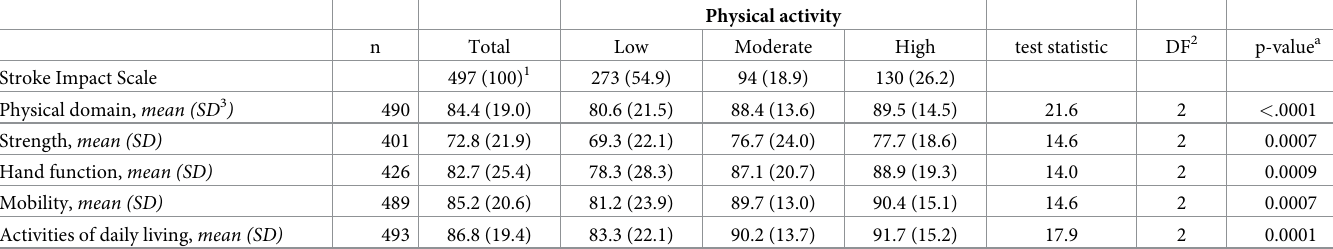
Table 2. Stroke Impact Scale scores at follow up, overall and stratified by pre-stroke physical